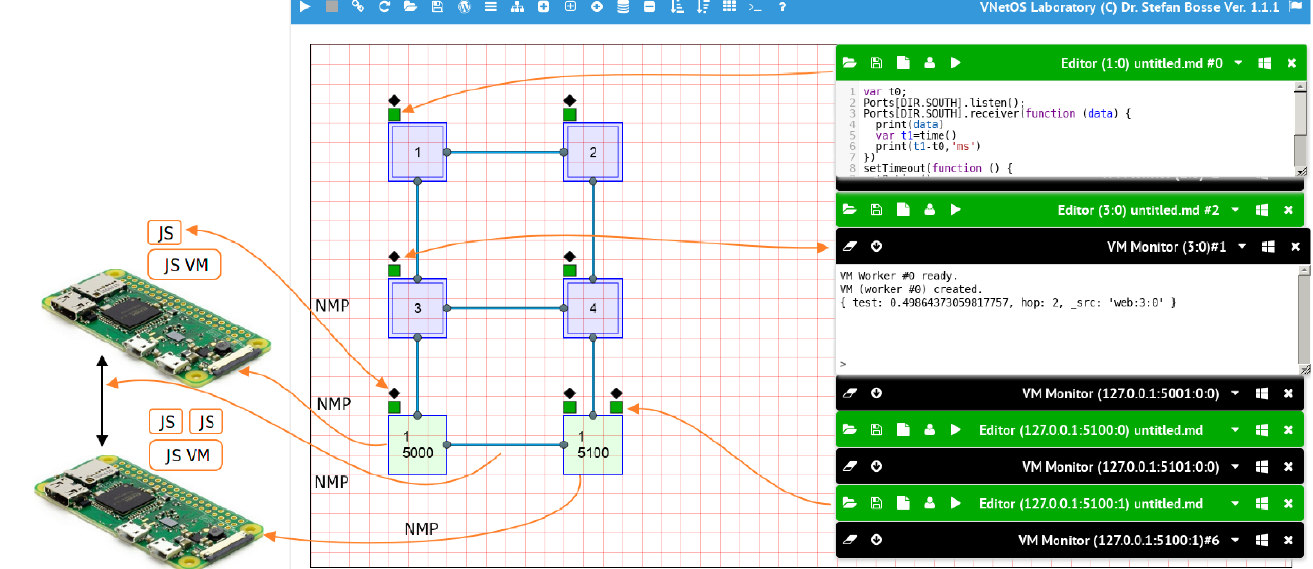
Figure 3. Typical network application using VNetOS, a Web browser, and two external Raspberry PI devices. Double-outlined boxes are internal nodes, single-outlined are wrappers for external nodes. Small squares and diamonds are connectors to editor and shell windows (right side). Orange lines represent communication with external nodes using NMP.